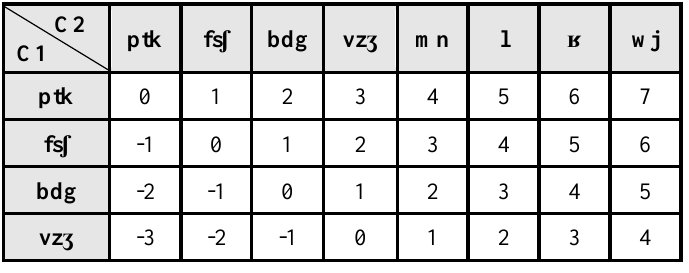
Table 7. Sonority Distance between C1 (last consonant of the first word) and C2 (first consonant of the second word).